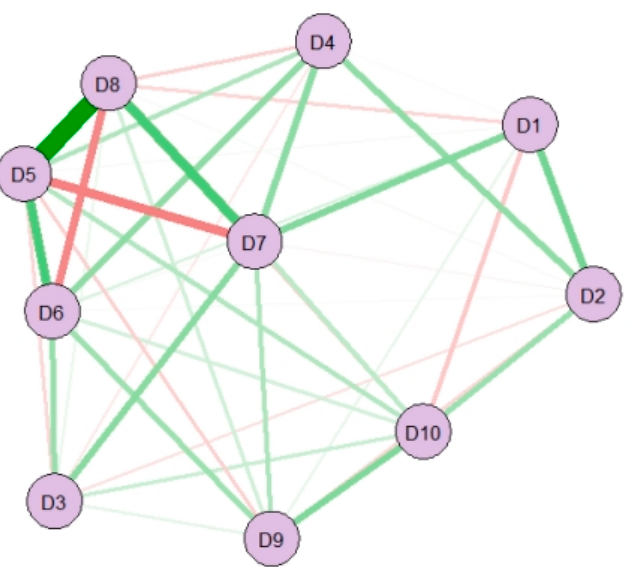
Figure 2. Network structure of depression. Note. D1 = bothered by things; D2 = difficulty keeping mind; D3 = depressed mood; D4 = everything is an effort; D5 = hopelessness about the future; D6 = fear; D7 = poor sleep; D8 = unhappiness; D9 = loneliness; and D10 = could not get going. Nodes represent depression symptoms and edges represent partial correlations between symptoms. Green and red edges represent positive and negative associations, respectively. Line thickness reflects associ- ation strength. The stronger and saturated edges represent stronger regularized partial